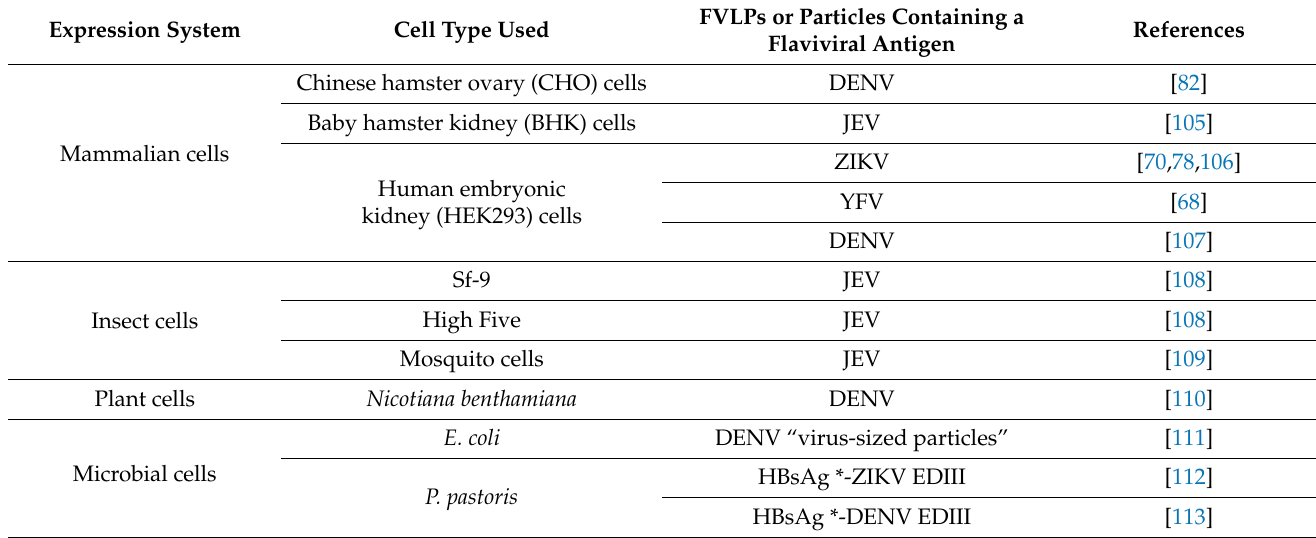
Table 2. Examples of expression systems used for production of flavivirus-like particles or other biological particles bearing flaviviral